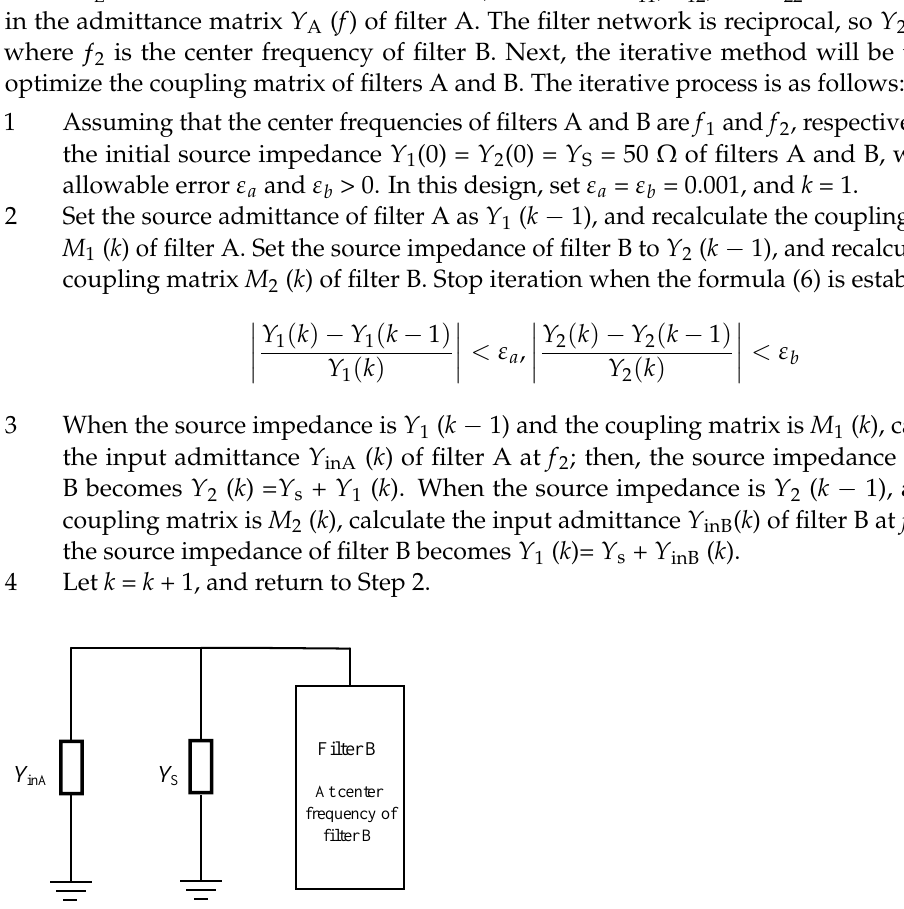
Figure 2. Schematic diagram of source complex admittance.